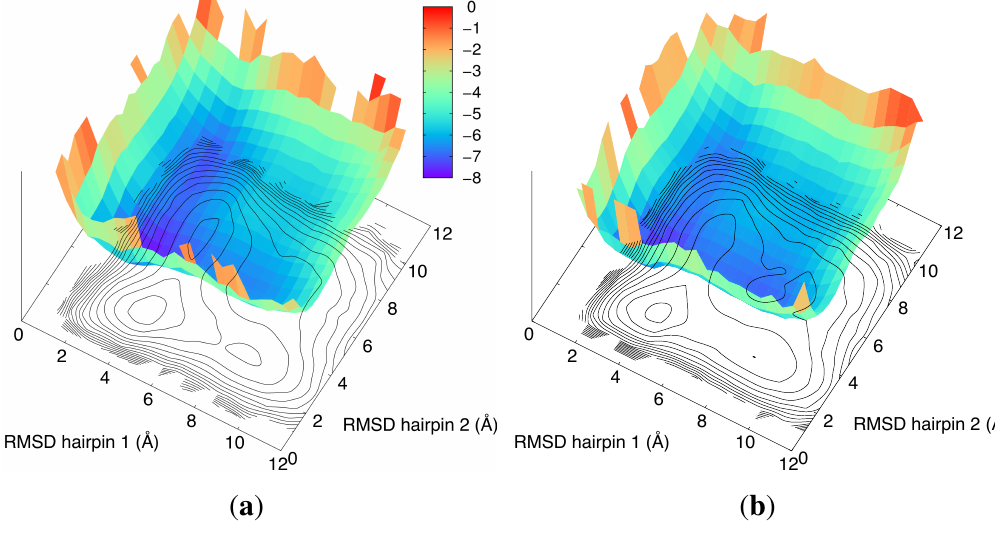
Figure 3. Free-energy landscape of fip35 computed in the two-dimensional coordinate space defined by the RMSD relative to the native coordinates of the respective hairpins. Contour lines are separated by a change of 0.8 kcal/mol in the free energy. The same scale is used for the color panel. The data in panel ( a ) pertain to Monte Carlo folding simulations employing a purely native-centric coarse-grained model; the data in panel ( b ) incorporate, in addition, non-native quasi-chemical interactions. Adapted with permission from